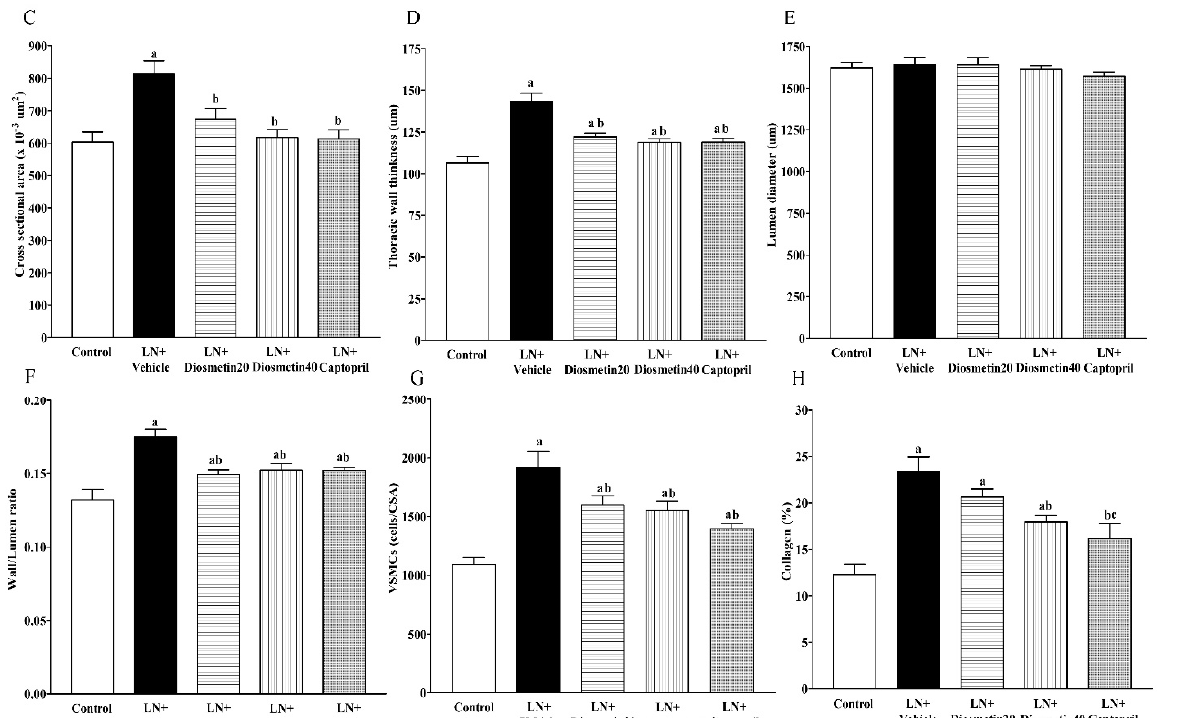
Figure 7. Effect of diosmetin and captopril on the vascular morphology in LN-induced hypertensive rats. Representative